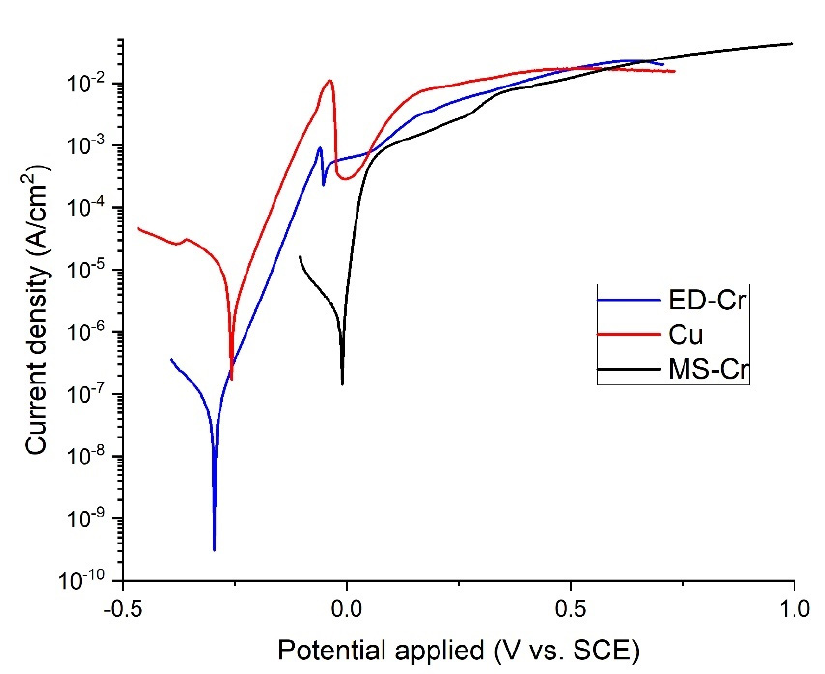
Figure 6. Potentiodynamic curves of ED-Cr and MS-Cr chromium coatings compared with the bare copper substrate in aerated 3.5% NaCl solution. Table 2. Electrochemical corrosion